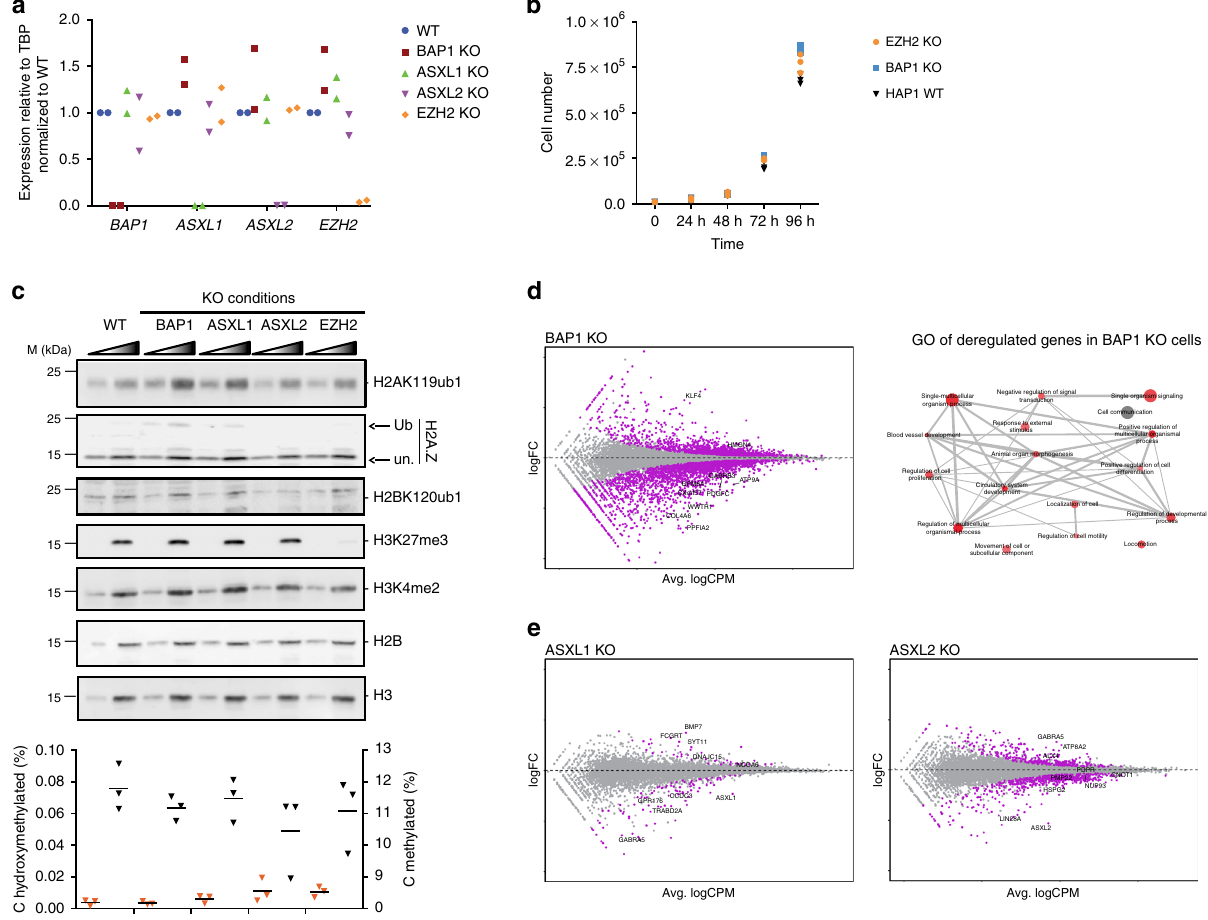
Fig. 1 Functional consequences of loss of BAP1, ASXL1, or ASXL2 on chromatin and gene expression. a RT-qPCR analysis of BAP1 , ASXL1 , ASXL2 , and EZH2 expression in the different KO conditions indicated on top. n = 2. b Proliferation curve of wild-type, EZH2 KO and BAP1 KO HAP1 cells. n = 3. c Top, western blot analysis of acid extracted histones with antibodies directed against various histone modi fi cations (as indicated on the right) in the different cell lines indicated on top, M molecular weight. A two-point titration (1:2.5 ratio) is shown for each condition, ub ubiquitinated, un unmodi fi ed. Bottom, analysis of cytosine methylation (blue triangles) or hydroxymethylation (red triangles) in the KO conditions indicated at the bottom. Horizontal bars indicate the mean. n = 3. d Left panel: scatterplot showing log2 fold-change (logFC) expression between wild-type and BAP1 KO cells versus average log2 counts per million (logCPM). Differentially expressed genes (DEGs) in BAP1 KO cells are highlighted in purple. Right panel: representation of the non-redundant most enriched GO terms within the DEGs in BAP1 KO cells. e Scatterplots as in d , showing gene expression changes in ASXL1 and ASXL2 KO